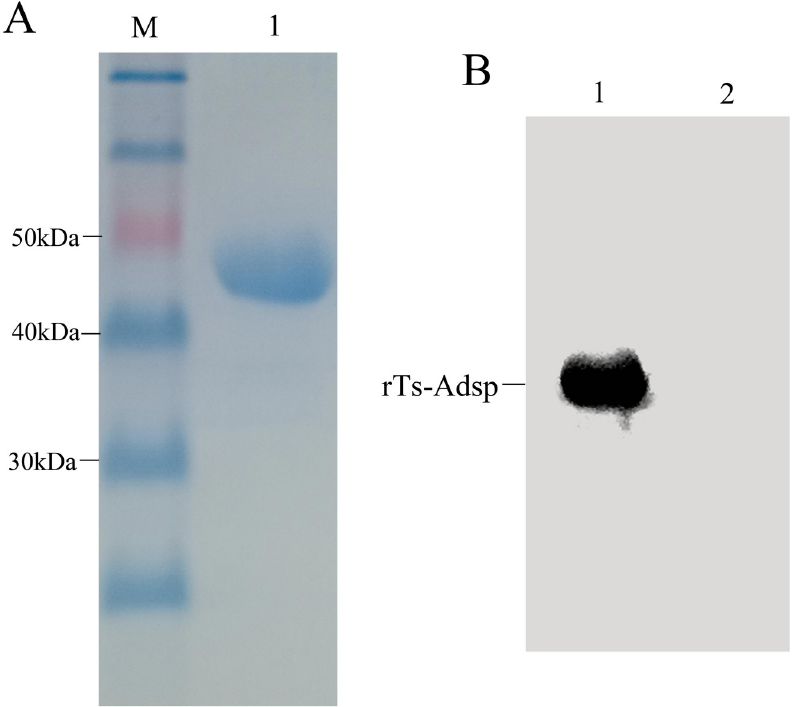
Fig 1. Purification and identification of recombinant rTs-Adsp by SDS-PAGE and western blot. (A) Purified rTs- Adsp was analyzed by SDS-PAGE. Lane M: protein molecular weight marker, Lane 1: purified rTs-Adsp by Ni-affinity chromatograph. (B) The antigenicity of rTs-Adsp was identified by western blot. Lane 1: rTs-Adsp incubated with serum from pig infected with T . spiralis at 60 dpi, Lane 2: rTs-Adsp incubated with serum from Trichinella –negative